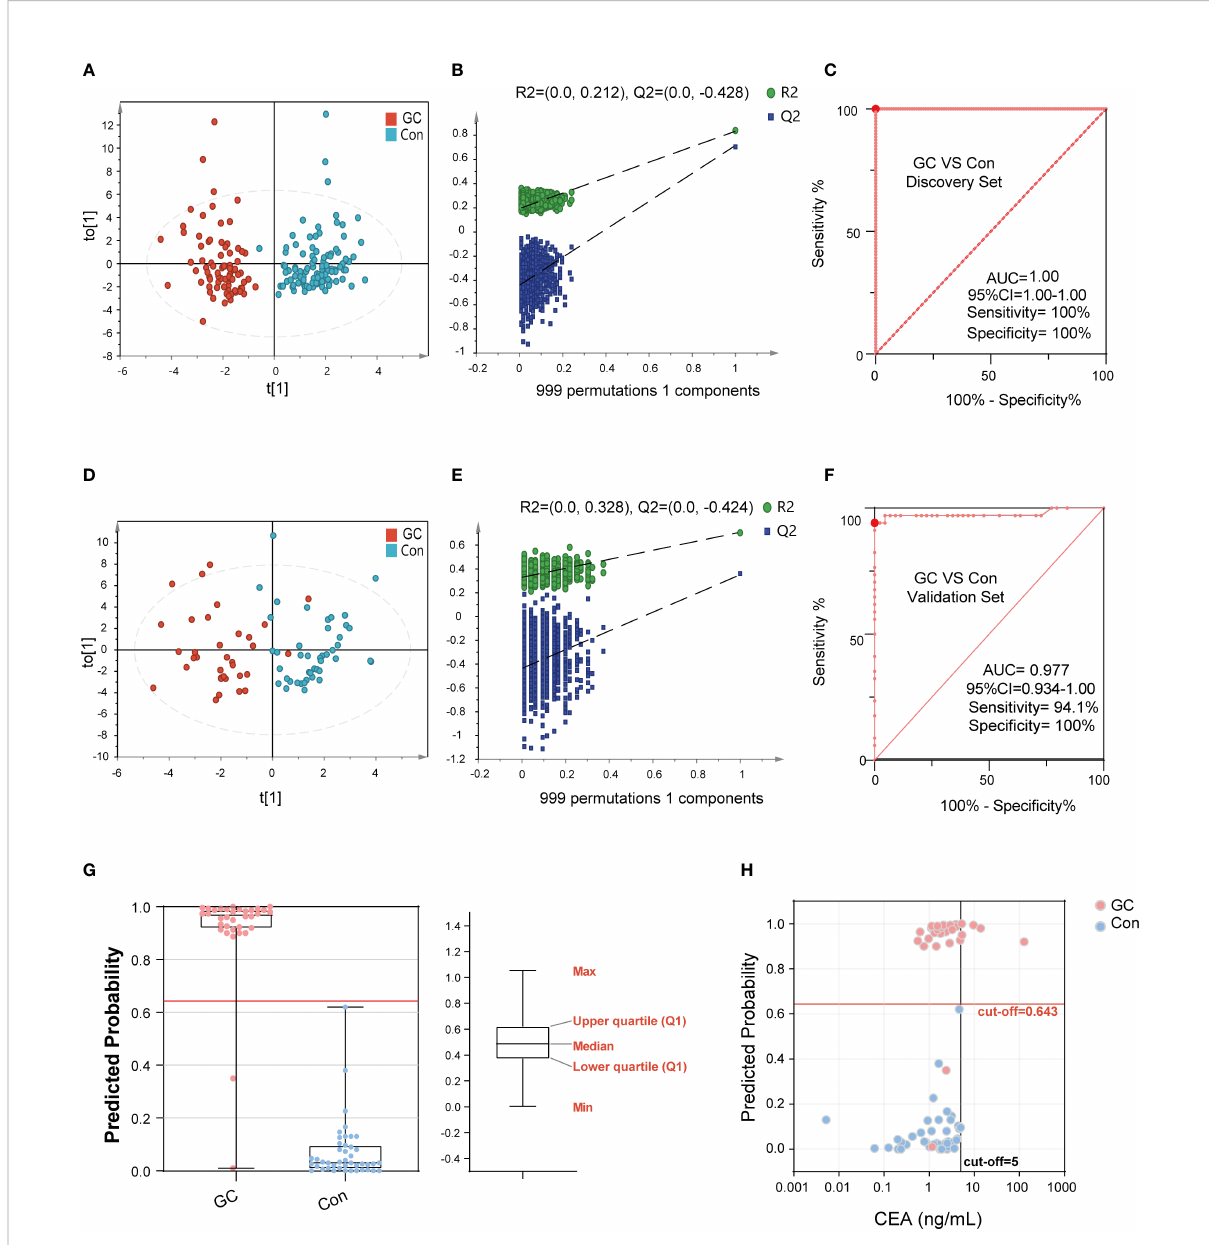
FIGURE 4 The performance of BA biomarkers in distinguishing GC and Con group. The OPLS-DA score plot of the GC and Con groups in discovery set (A) . The permutation test result of the above OPLS-DA, which could verify whether the classi fi cation is over fi tted (B) . The ROC curve of 6-BAs diagnostic panel between the GC and Con group, which was constructed using the discovery set (C) . The OPLS-DA score plot of the GC and Con groups in the validation set (D) . The permutation test result of the above OPLS-DA. (E) The ROC curve of 6-BAs diagnostic panel between the GC and Con group, which was constructed in discovery set and test in validation set (F) . Predicted probability of the 6-BAs diagnostic panel identi fi ed in the discovery set and applied to the validation set (G) . Scatter plot for comparing the 6-BAs diagnostic panel and CEA. The CEA concentration of the Con is randomly selected from the upper limit of the normal value and zero (H)